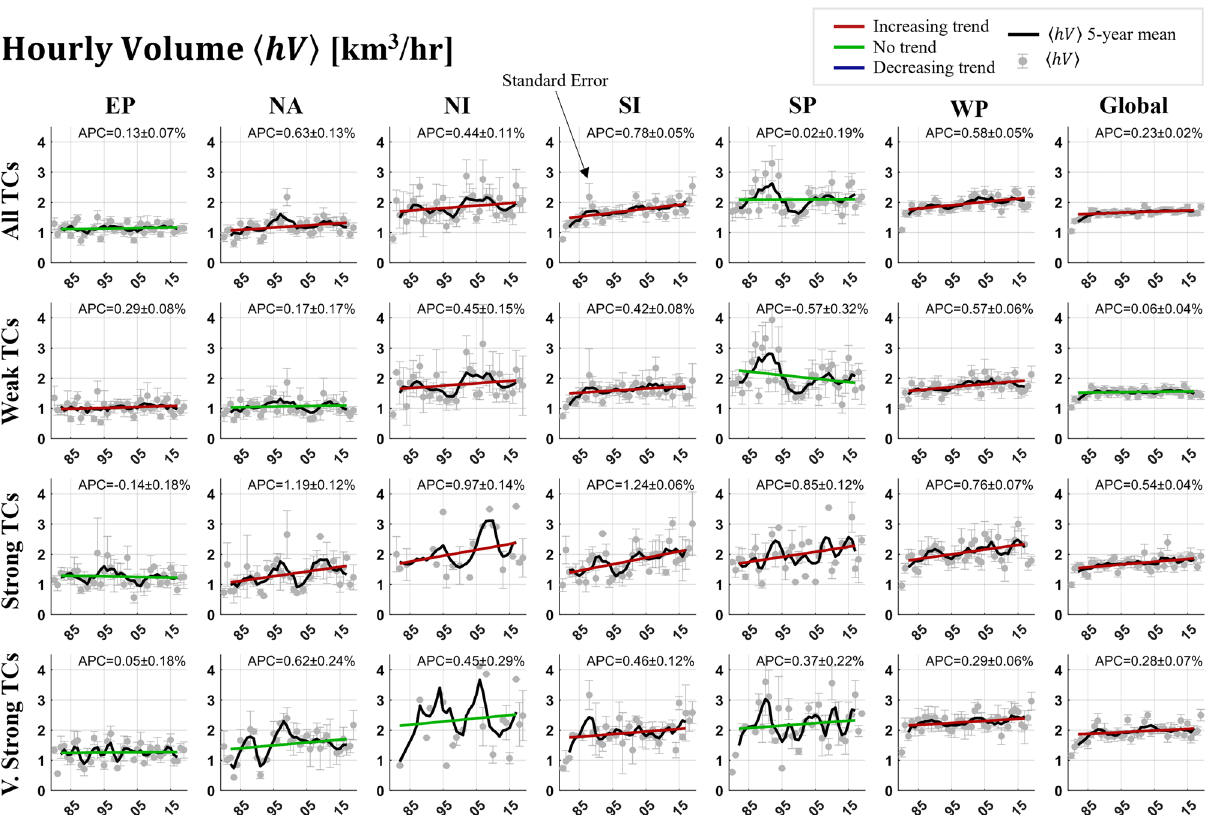
Figure 3. Trend analysis of mean hourly TC precipitation volume totals ( (cid:31) hV (cid:30) ), separated by intensity and basin classifications. The symbology and features are identical to those from Fig.